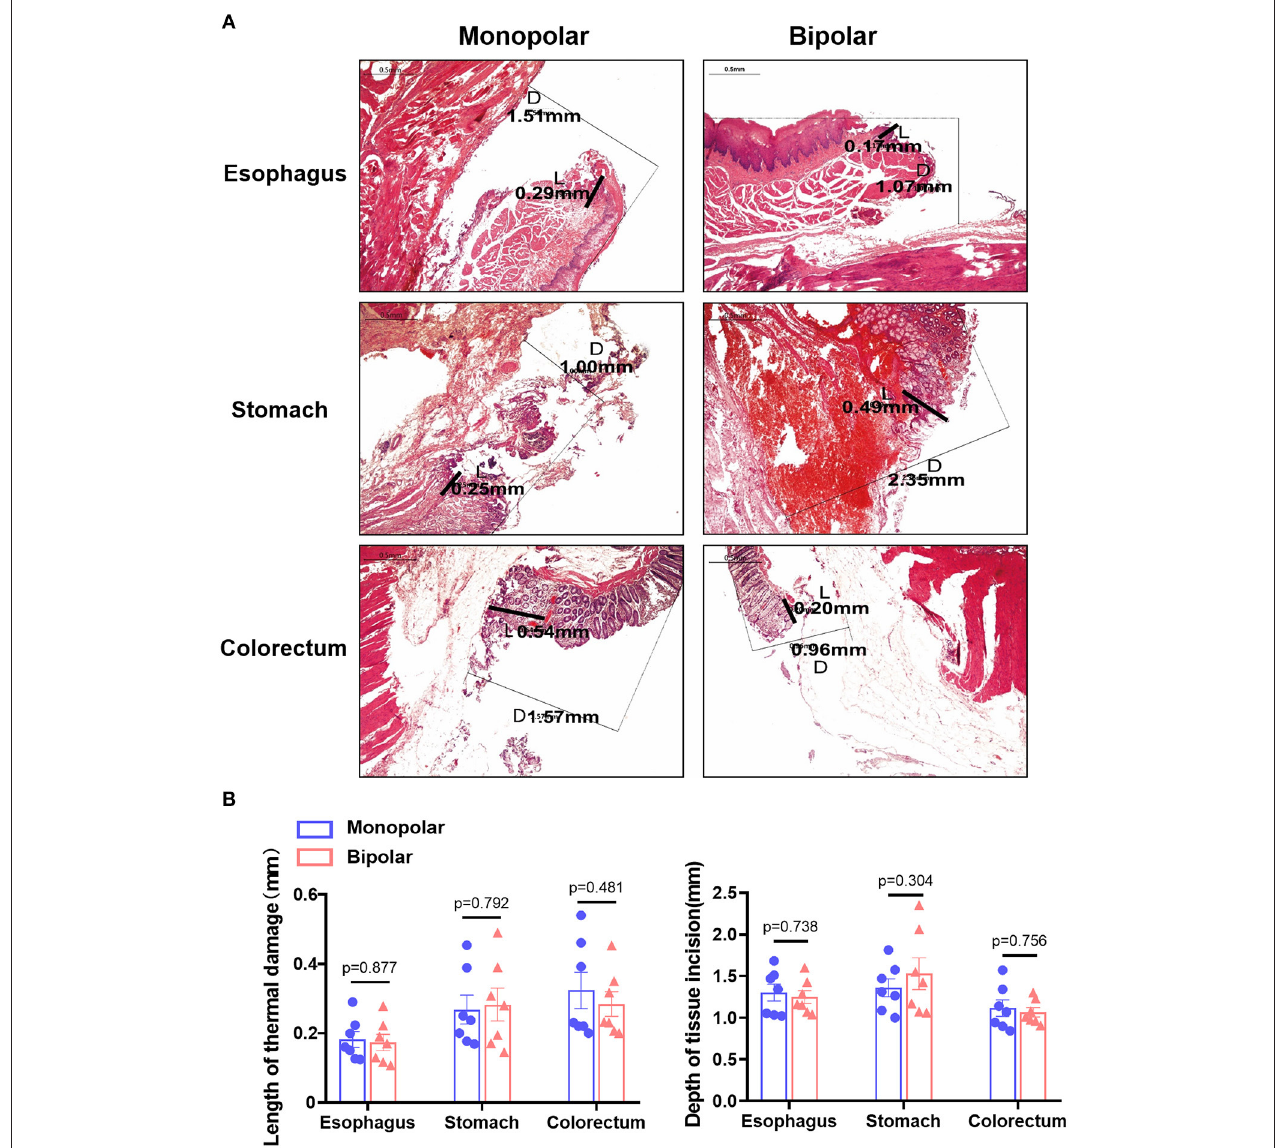
FIGURE 4 | The digestive tract acute damage caused by the monopolar and bipolar knives during ESD operation. (A) H&E staining of porcine esophageal, gastric, and colorectal mucosa resected with the two knives. Scale bar: 0.5mm. L: thermal damage length (range); D: incision depth; (B) Compare the length and depth of thermal damage between the monopolar and bipolar groups in esophagus, stomach, and colorectum at acute time